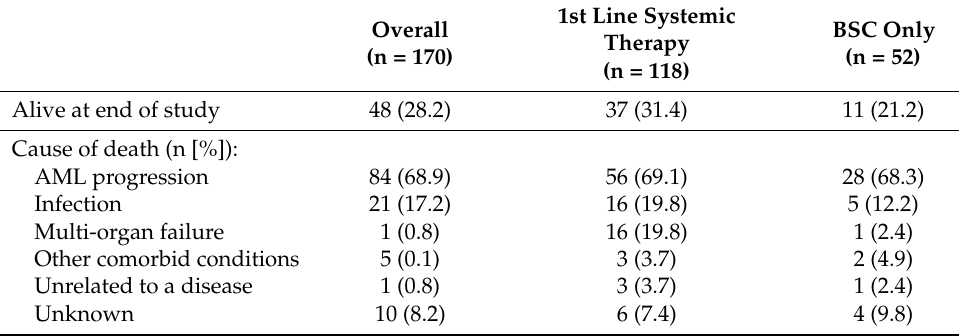
Table 3. Patient outcomes at the end of